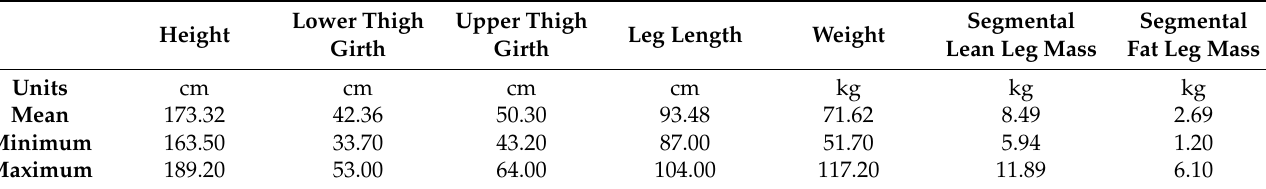
Table 3. Descriptive statistics of the relevant body